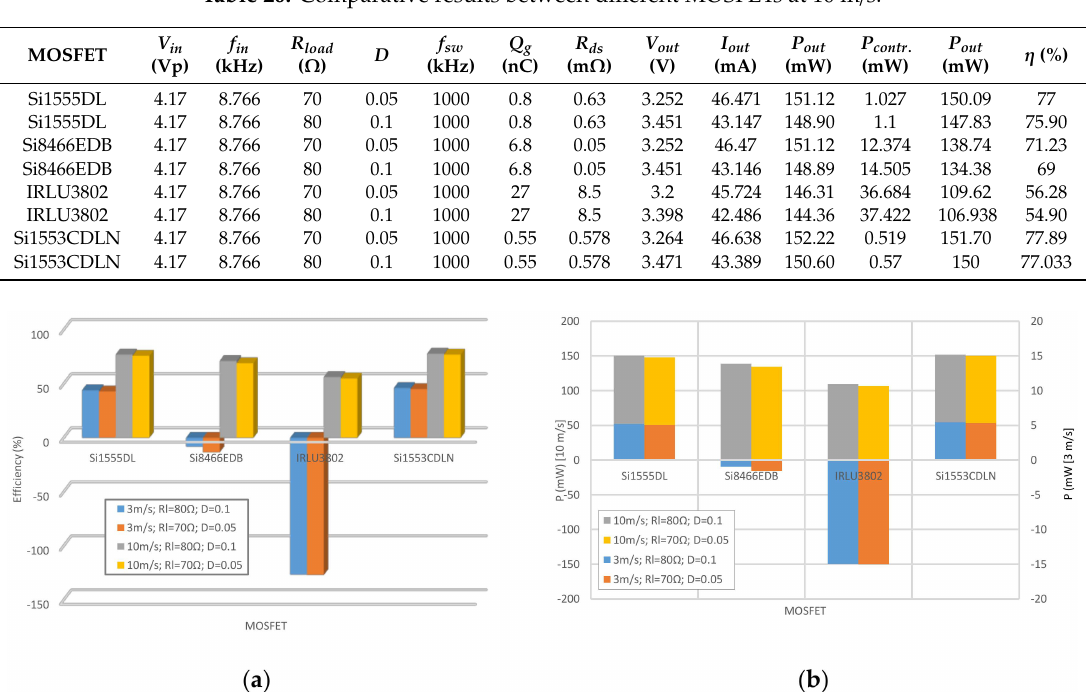
Table 20. Comparative results between di ff erent MOSFETs at 10 m / s.